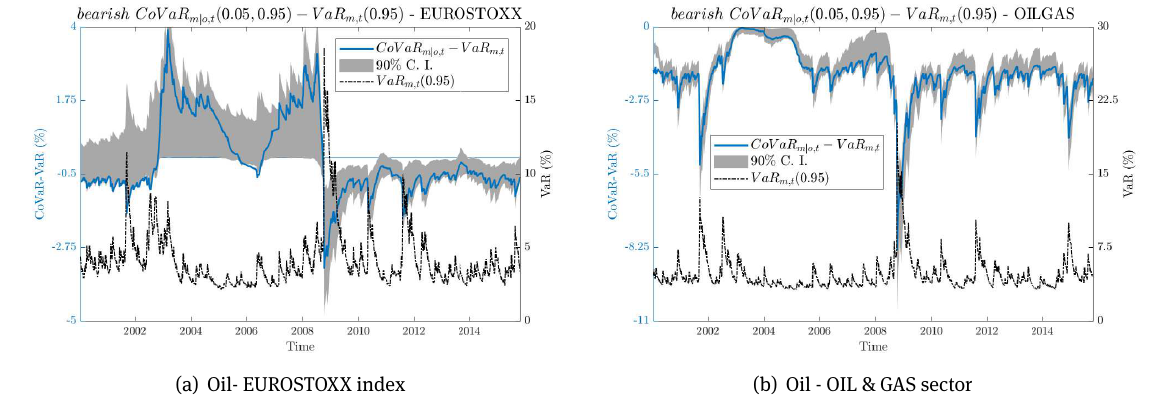
Figure 16a: CoVaR m | o , t (0.05, 0.95) for a certain sector given a bearish scenario for oil prices